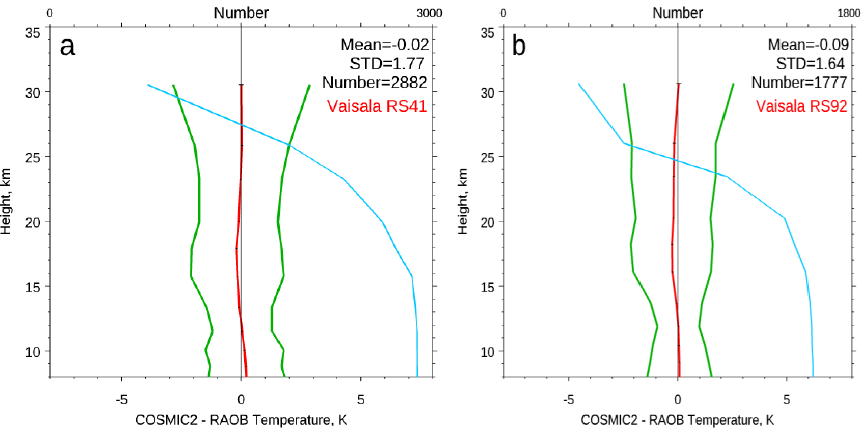
Figure 10. The temperature comparisons from 8 km to 32 km altitude for ( a ) COSMIC-2 and RS41 pairs, and ( b ) COSMIC-2 and RS92 pairs. The sample numbers are in the blue line, the mean differences are in red line, and the standard deviation values are in green line.